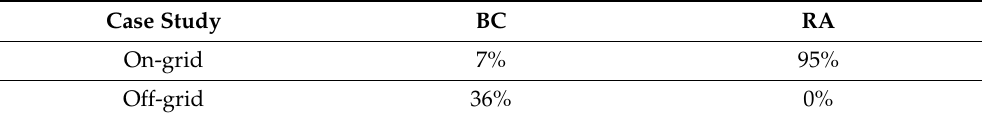
Table 4. State of charge of the ESS in different connection modes for different case